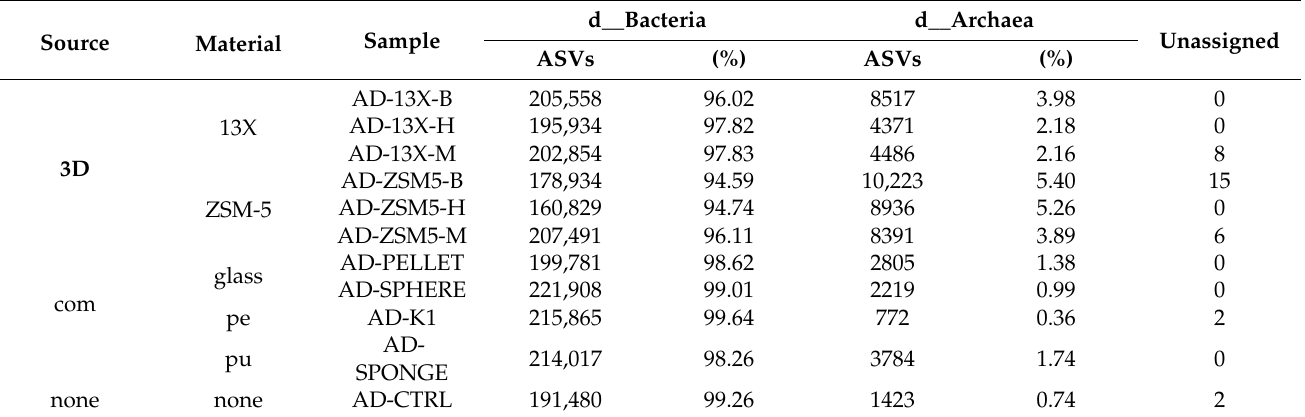
Table 3. Number and percentages of ASVs assigned to bacteria and archaea domain.